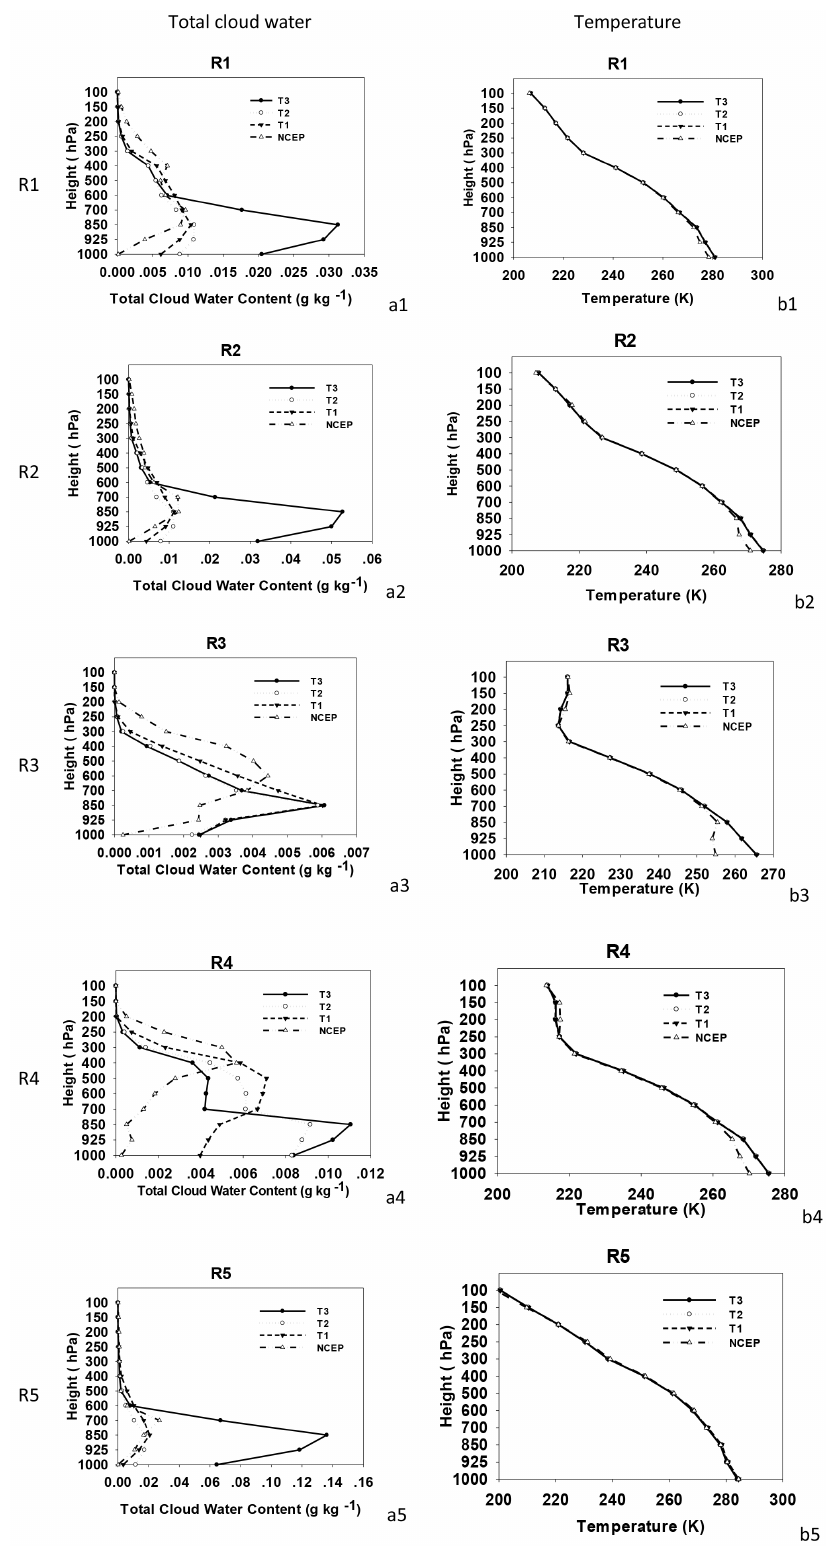
Figure 2. Vertical profiles of regional mean total cloud water content (a1 – a5) and temperature (b1 – b5) from 1000 to 100hPa for R1, R2, R3, R4, and R5. T1 denotes WSM6, the control test, T2 is the WDM6 with the K2000 activation scheme, and T3 denotes WDM6 with aerosol activated from CUACE. NCEP is for NCEP